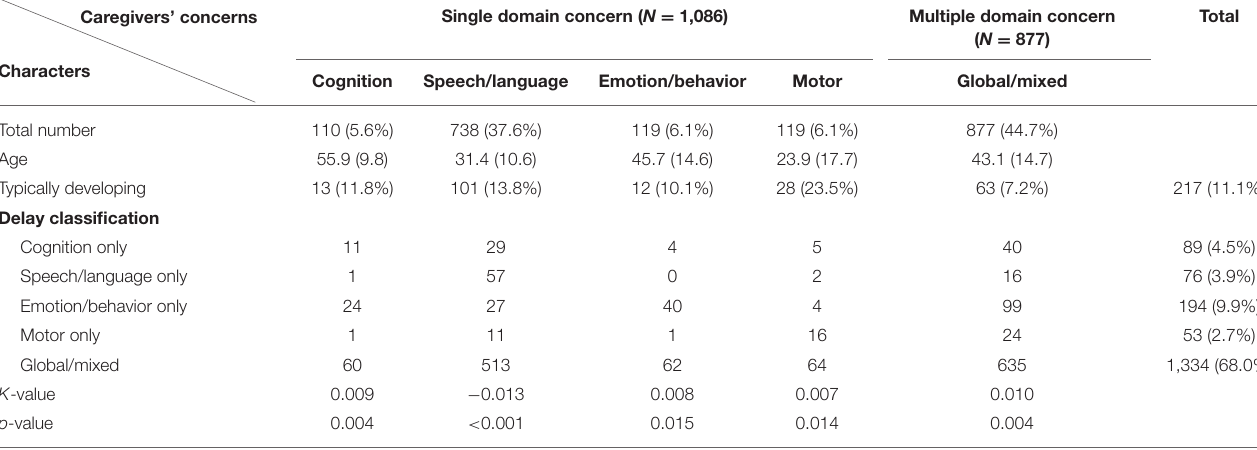
TABLE 2 | The caregivers’ concerns of children’s developmental problems and the results of professional identification ( N = 1,963).